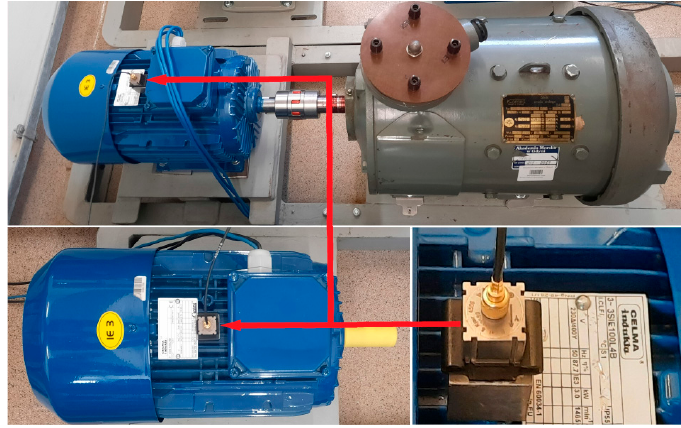
Figure 4. Motor3 Case B ( top ), motor3 Case A ( bottom left ) and the accelerometer ( bottom right ).